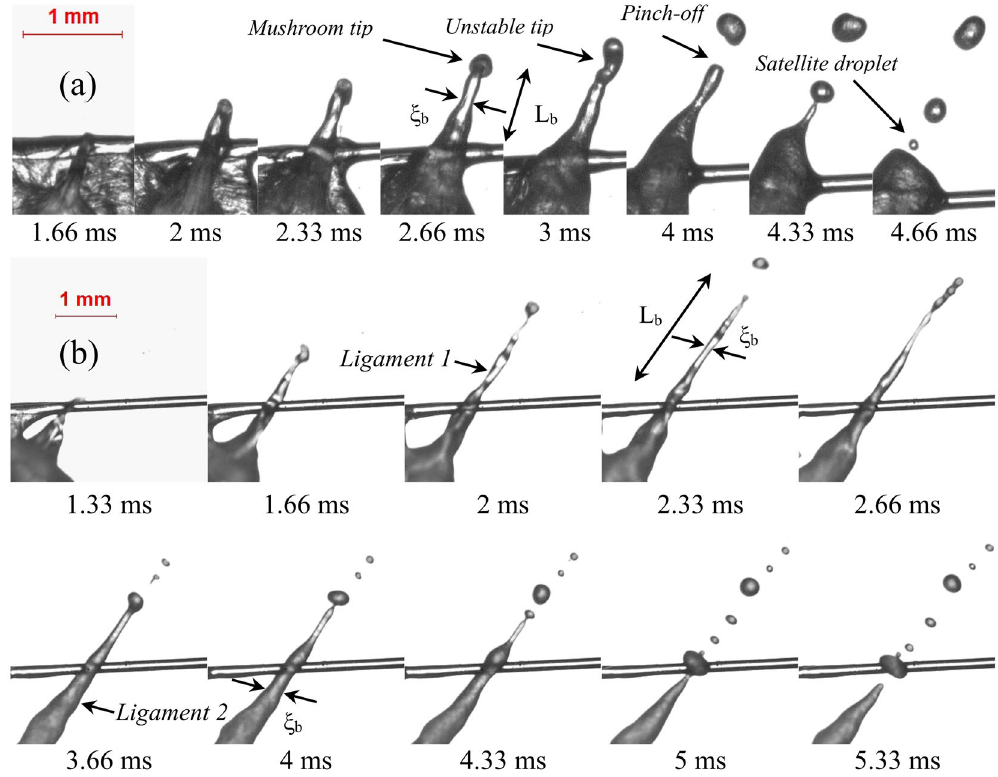
Figure 5. Ligament growth and breakup upon micro-explosion or complete disintegration of E50 droplets with ( a ) α = 3.2, AR = 3.72 ( b ) α = 5, AR = 17.